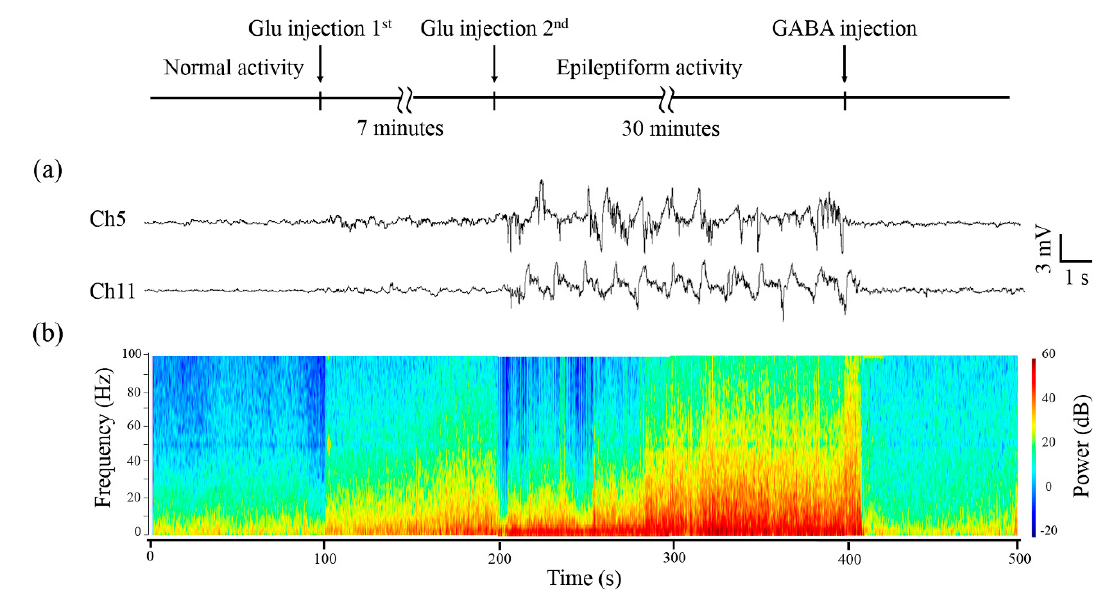
Figure 5. In vivo neural activity recording under modulation of glutamate (Glu) and gamma-aminobutyric acid (GABA). The arrow indicated the time of Glu injection (1st), (2nd), and GABA injection. ( a ) Real-time recording of local field potential (LFP) waveforms; ( b ) Time-frequency power spectrogram analysis.